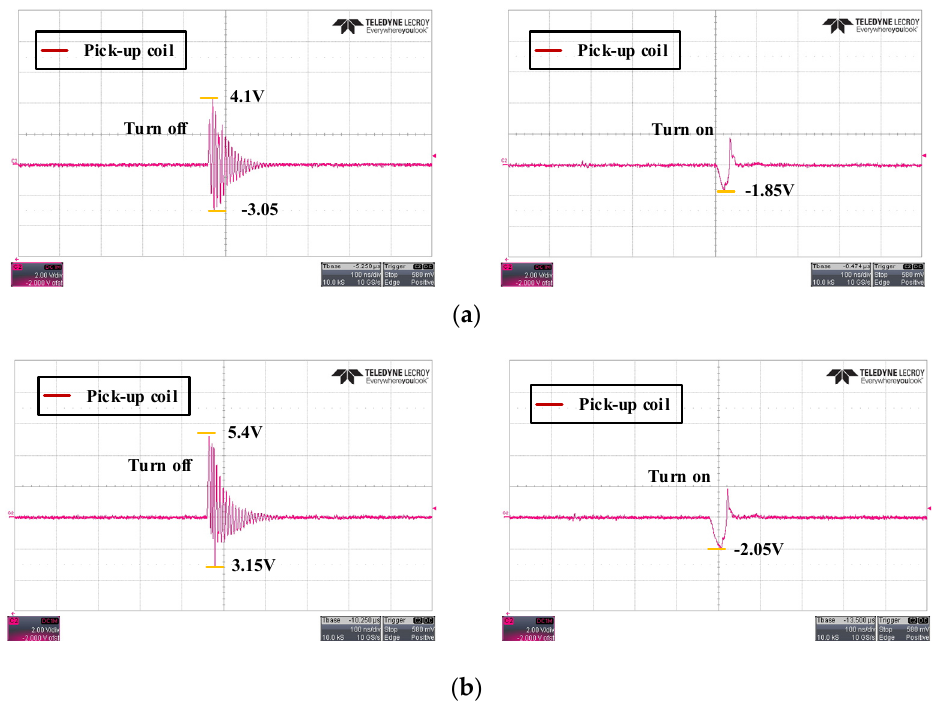
Figure 10. Measured coil output waveforms at 100-dc voltage: ( a ) spiral coil; ( b ) two-layer rectangular coil.